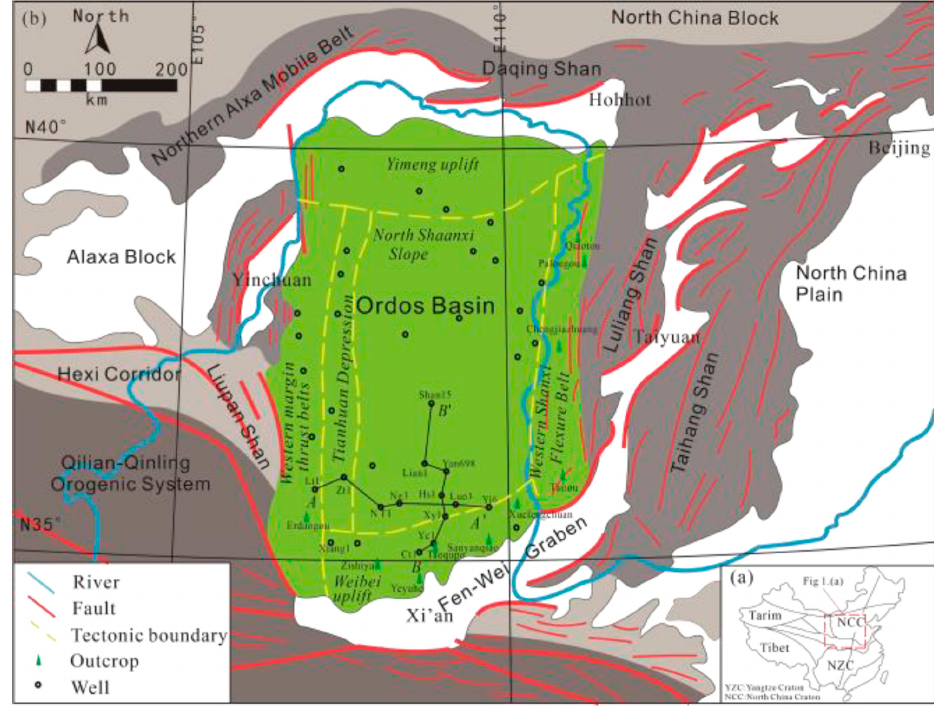
Figure 2. ( a ) Location of the Ordos basin in China. ( b ) Tectonic division and location of sampling wells, outcrops, and cross-sections in the Ordos Basin. (Adapted from Ref. [10]).